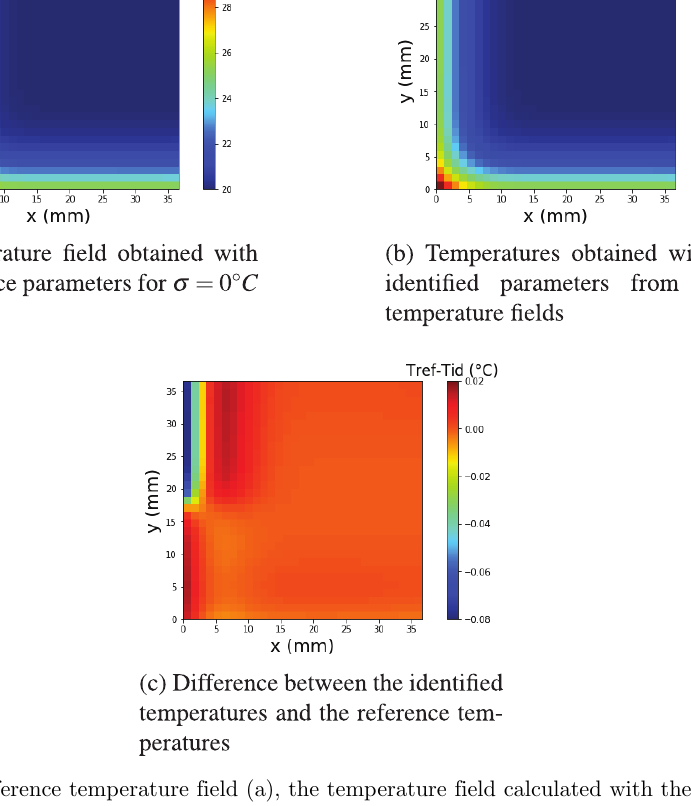
Fig. 7. Comparison between reference temperature field (a), the temperature field calculated with the identified parameters from noisy temperature field (b) and gap between the two fields (c), obtained for PA materials at time t = 80 s for M = 30 and dt = 4 s and σ = 0 . 4 ◦